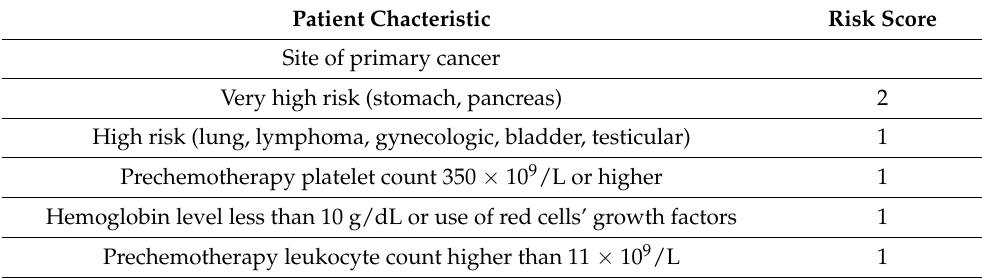
Table 3. Khorana score VTE risk assessment predictive model in cancer outpatients. Patient